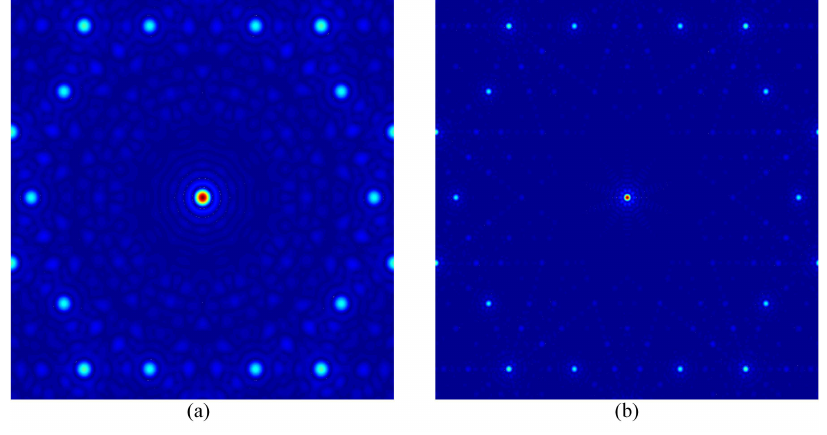
Figure 8. Normalized FT (magnitude) of a Penrose lattice with 371 points in ( a ) and with 1961 points in ( b